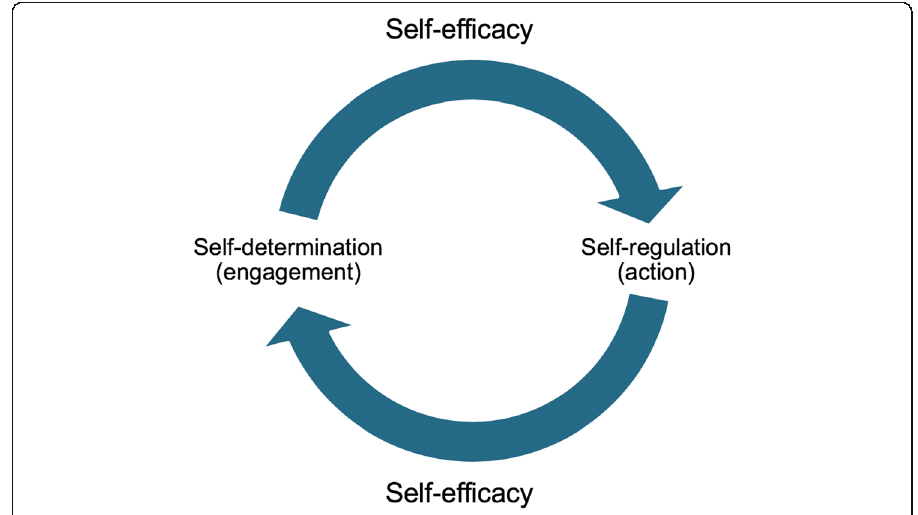
Fig. 1 The double dimension of self-direction in training (Carré, 2003, p.